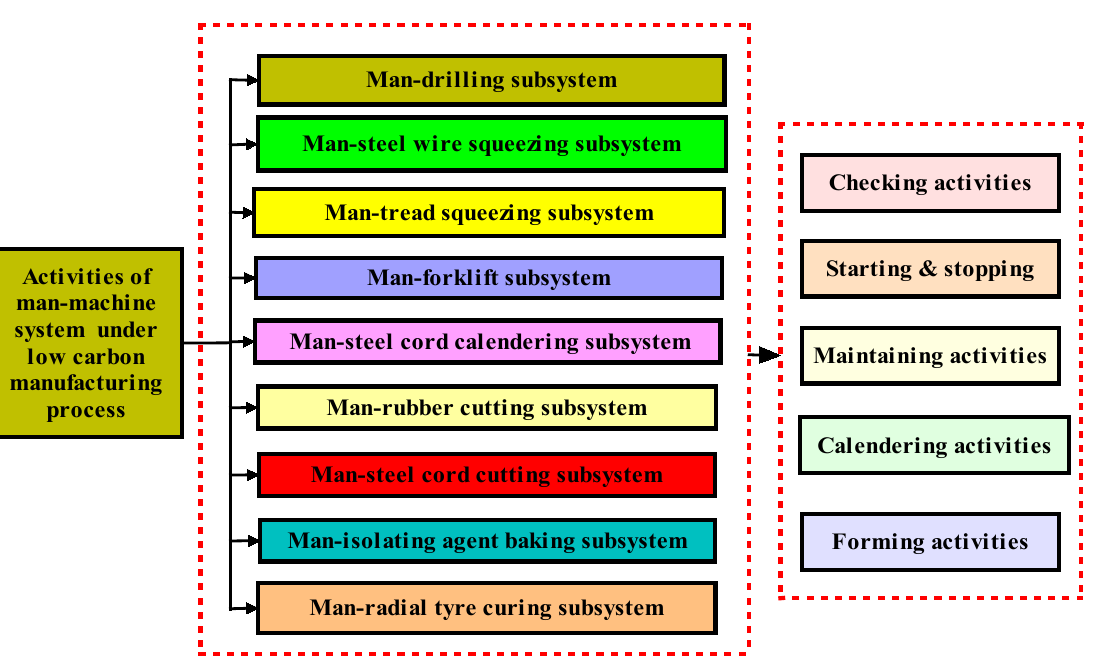
Figure 6. Man–machine safety system under a low carbon manufacturing process .